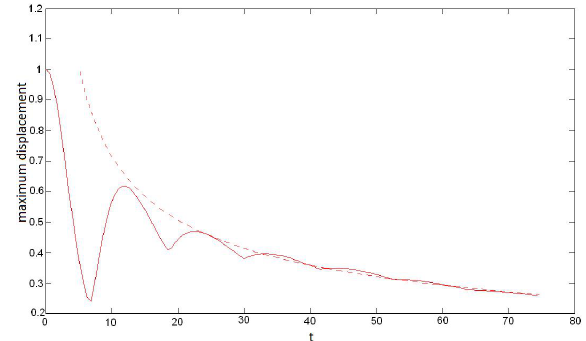
Fig. 2. The dependence of the maximum value of the wave field from dimensionless time (the solid line corresponds to the exact, and the dashed line – asymptotic